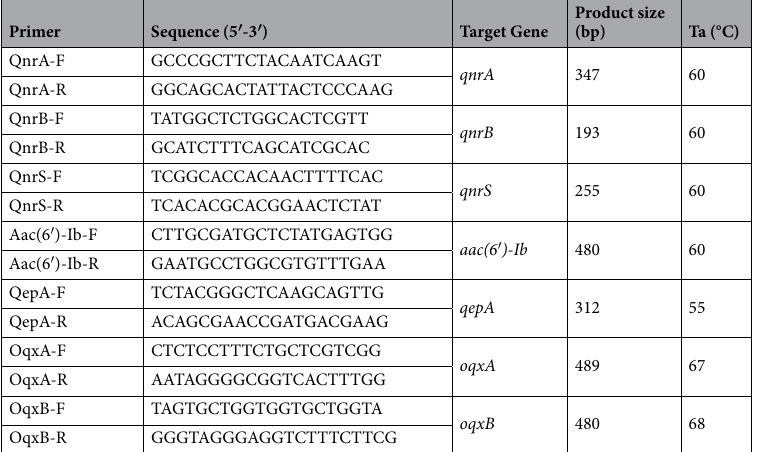
Table 5. Primers used for screening of PMQR genes. Ta, annealing temperature.